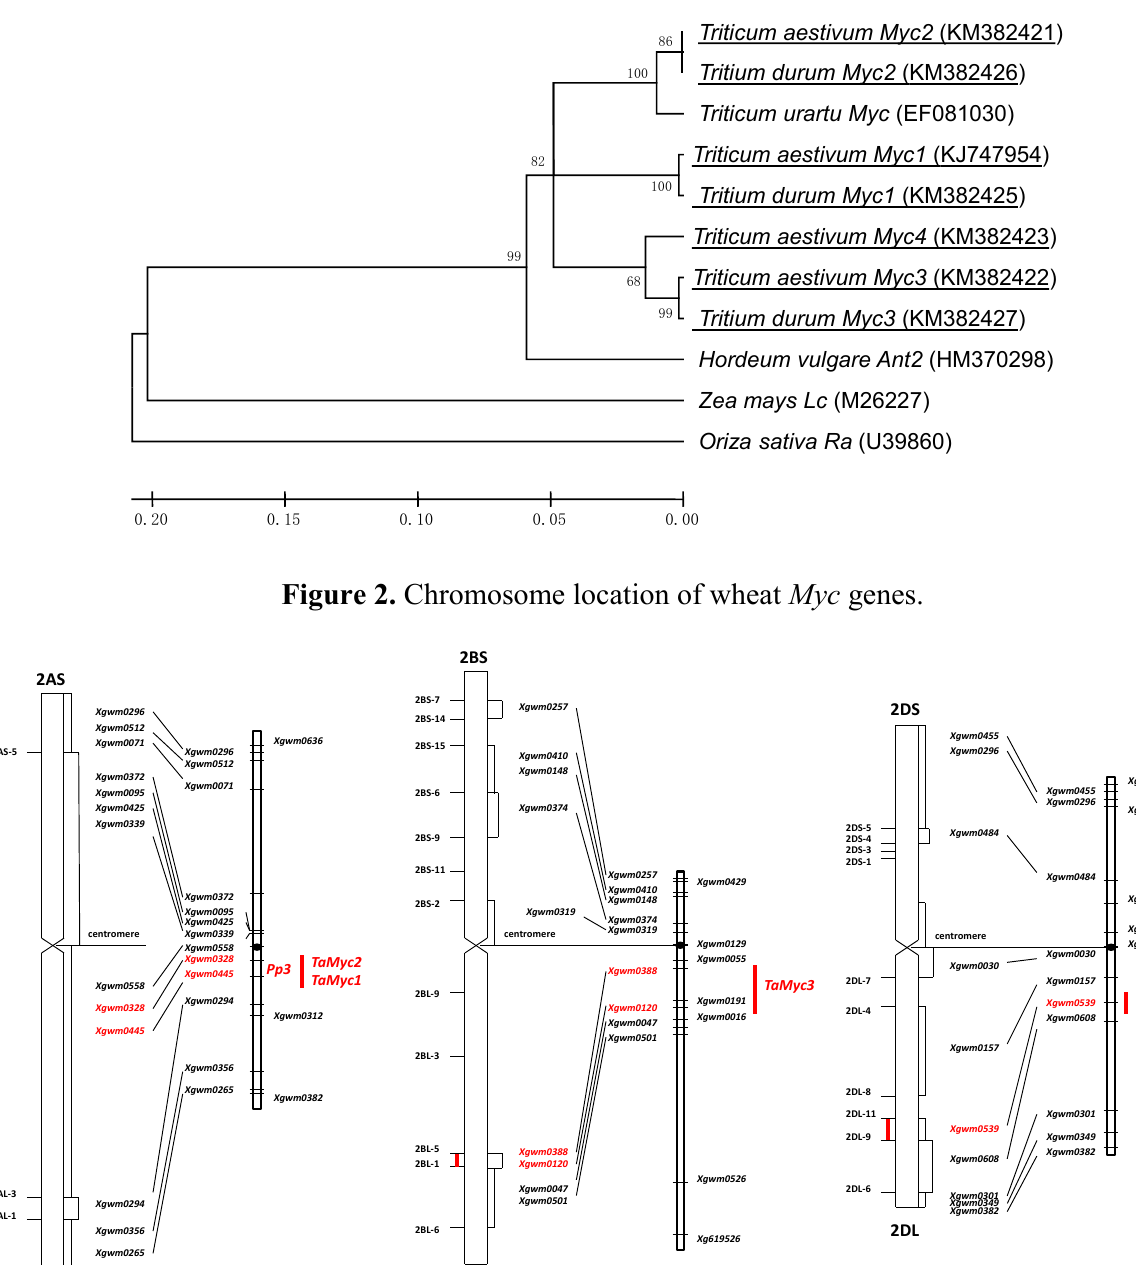
Figure 1. Myc -like sequence phylogeny. The sequences shown underlined were isolated in the current study, while the remainders were downloaded from GenBank.